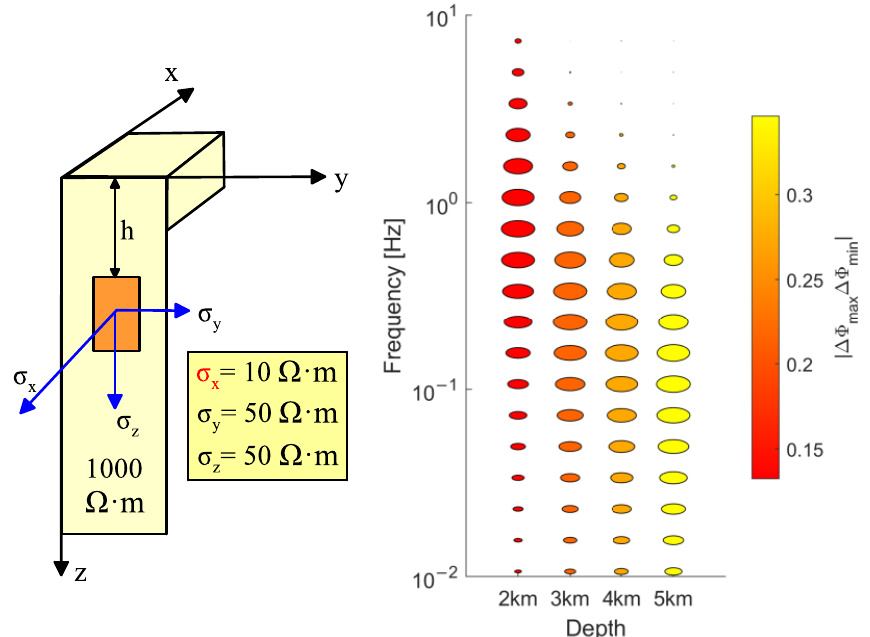
Figure 8. Fracture anisotropy model and the residual phase tensor with the change of the depth. The fractures with different depths can still respond to the residual PT, and the maximum electrical axis in the X direction can be observed. Along with the increase of the depth of the anomaly, the frequency of MT signal will decrease, and the resolution of anomaly characterization will also decrease. This is reflected in the attribute color value of the observation ellipse.